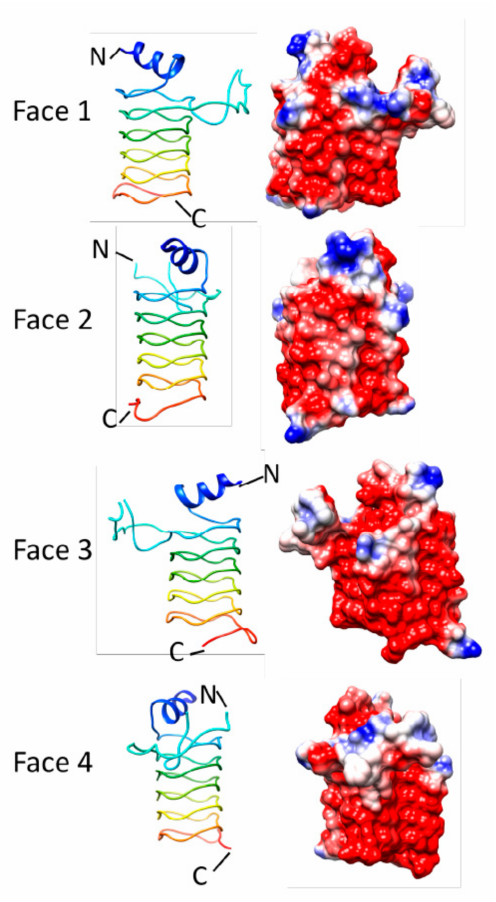
Figure 18. Structure and analysis of Rfr23. Ribbon diagrams of the structure (PDB ID: 2O6W) for four